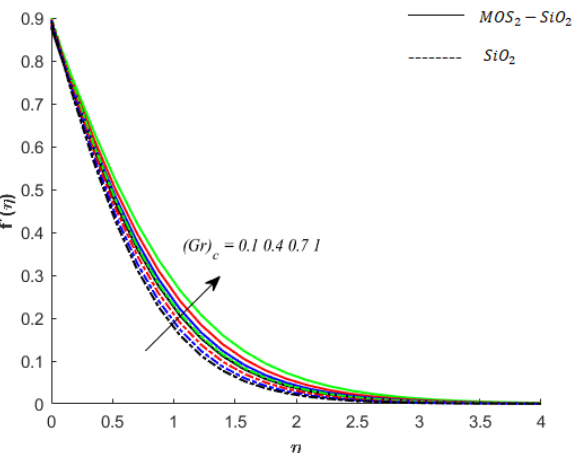
Figure 4. Influence of ( Gr ) on velocity when M = 0.9, Pr = 0.9, Ec = 0.2, Sc = 0.8, K = 0.1, Bi = 0.05, β ∗ = 0.1, γ = 0.1, γ 1 = 0.1.